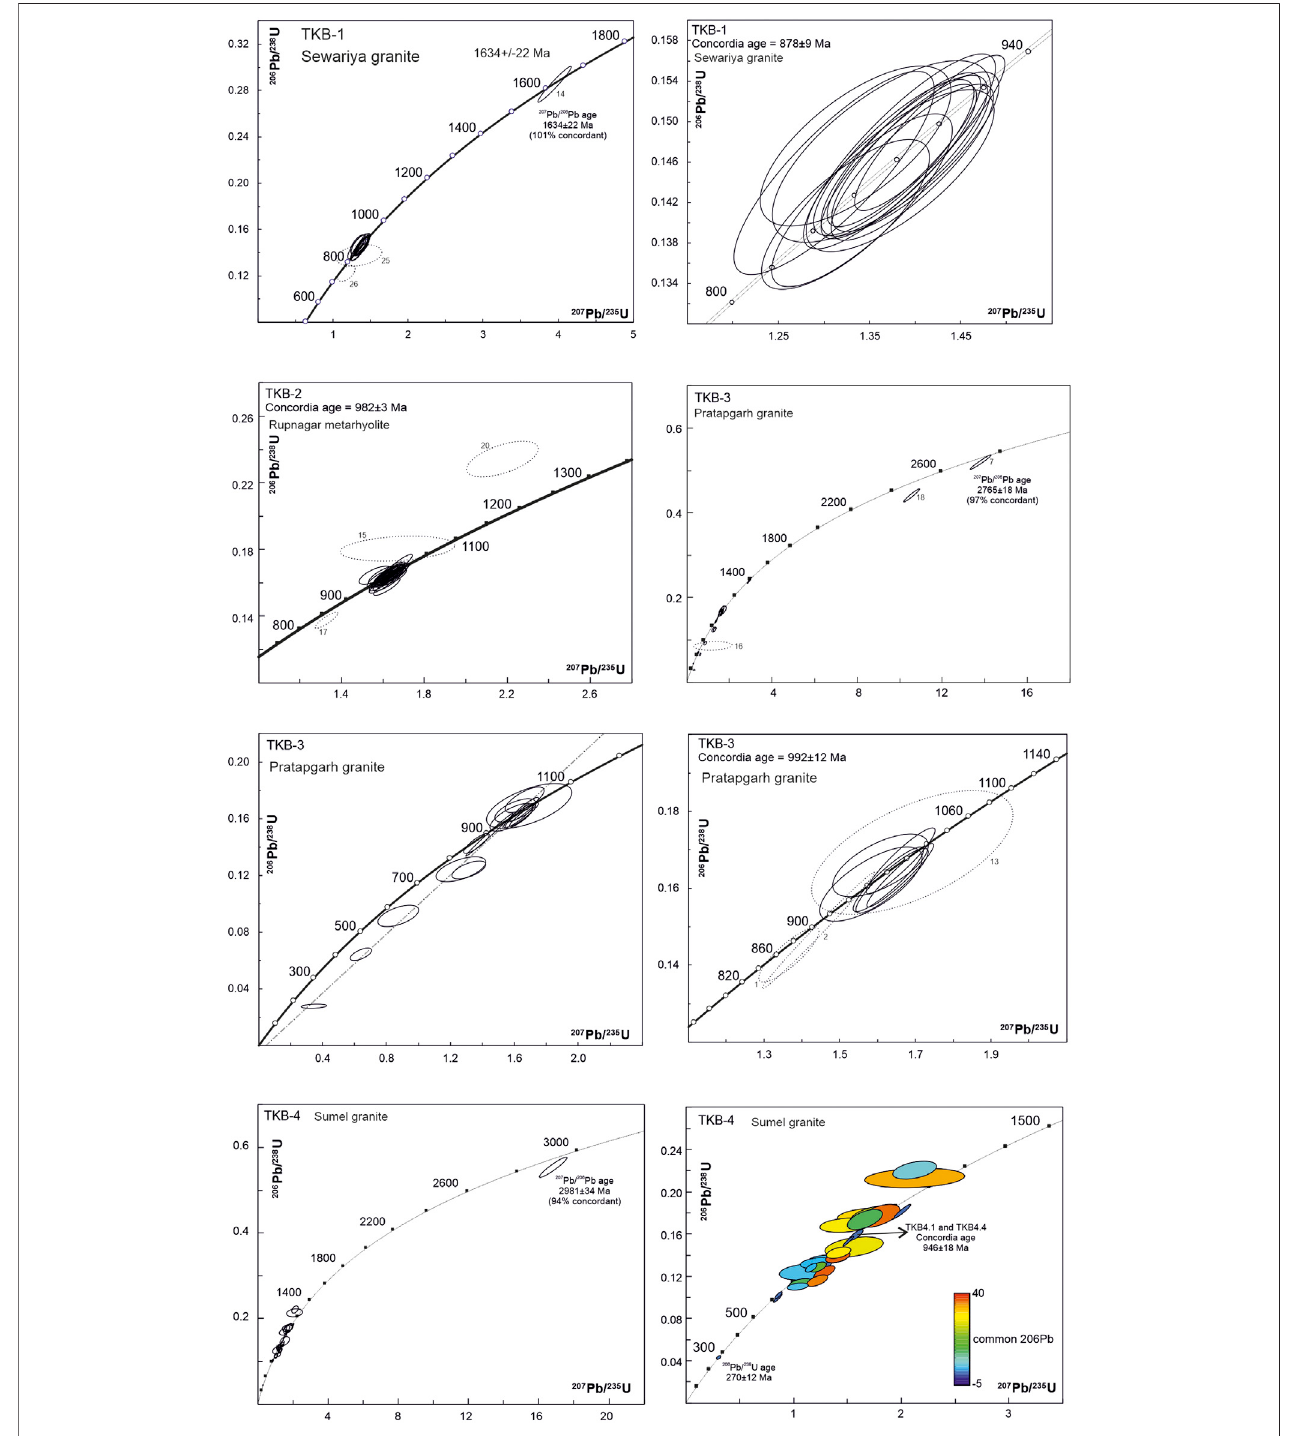
FIGURE 7 | Zircon U-Pb data for samples TKB-1, TKB-2, TKB-3, and TKB-4 locations are in Figure 2 . Errors are at 1 σ con fi dence level.